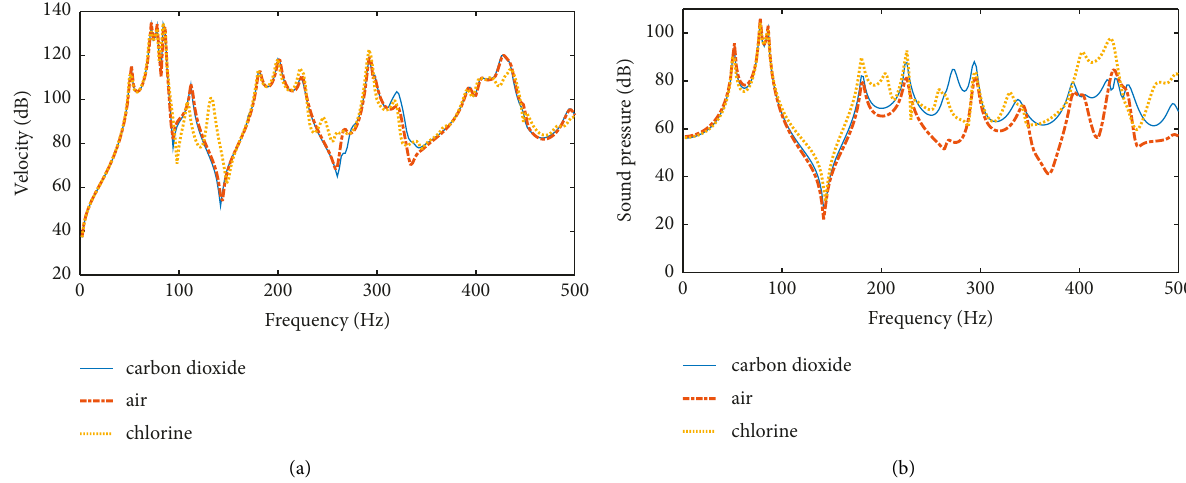
Figure 15: Vibration velocity response at the point on the surface of panel 2 and sound pressure response at the point in the acoustic cavity a with different acoustic cavity medium: (a) vibration velocity response and (b) sound pressure